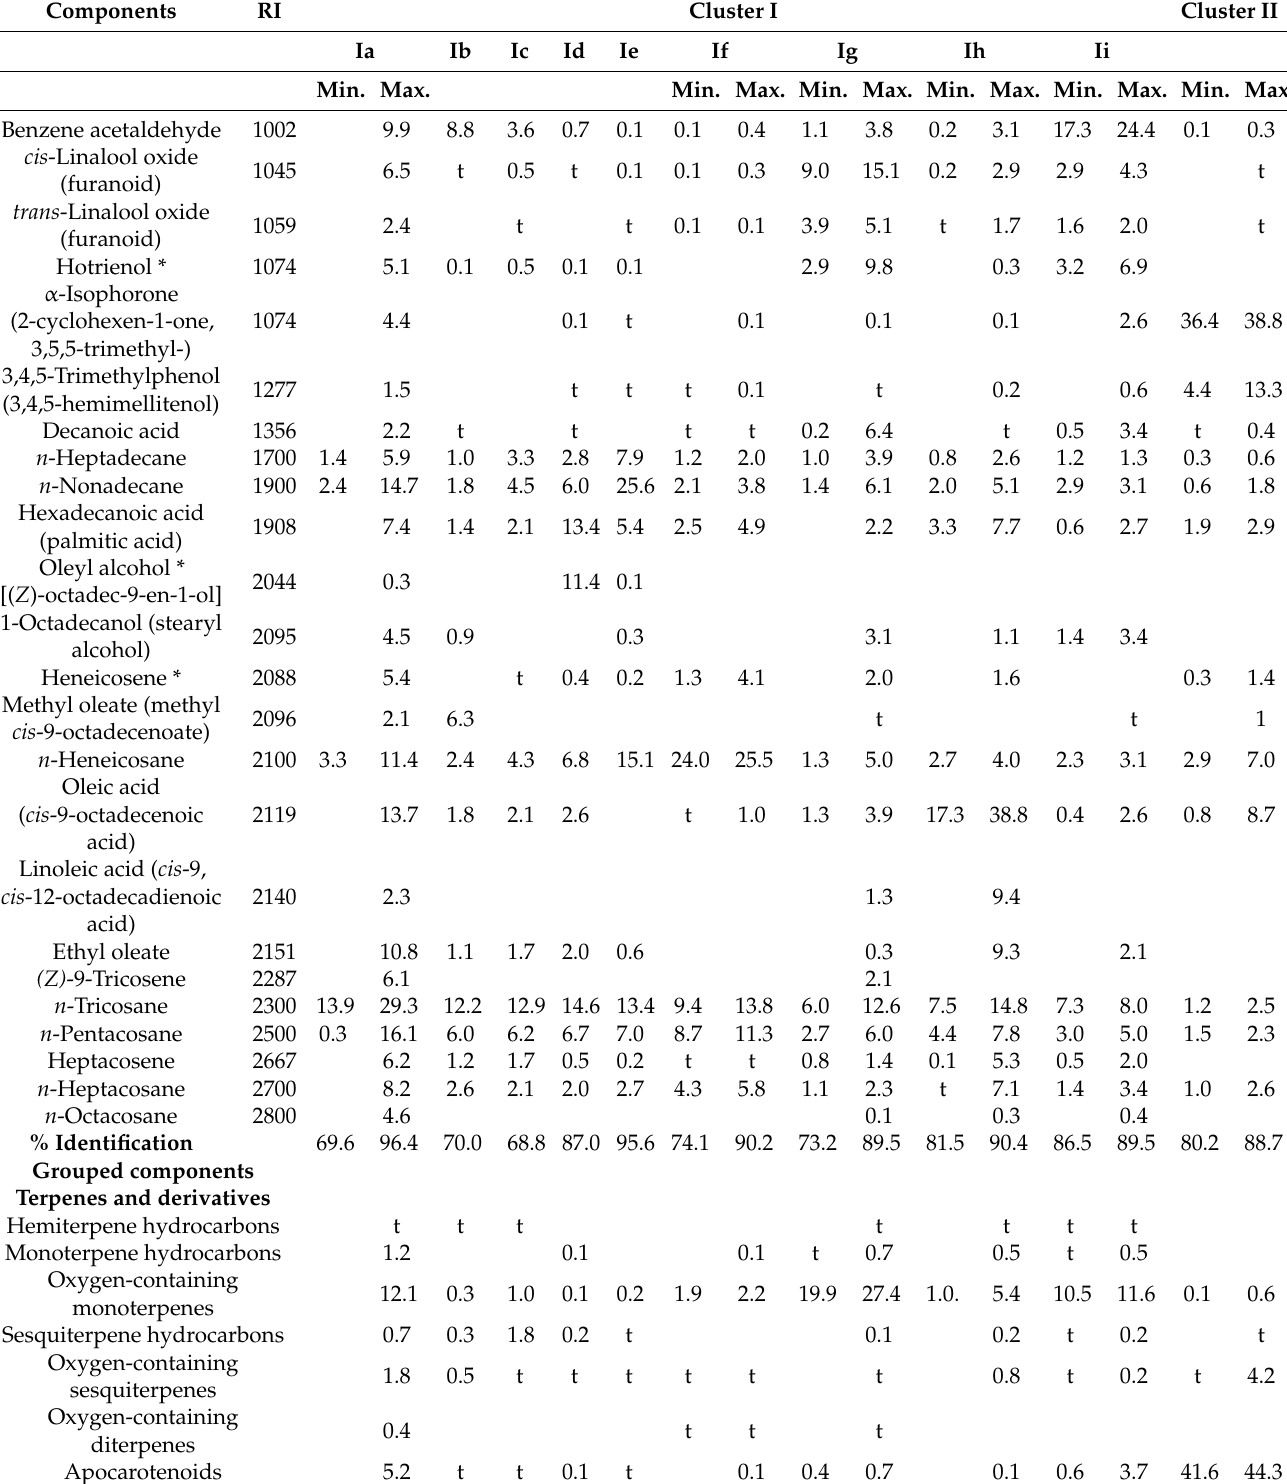
Table 2. Minimum and maximum percentage range of the main components ( ≥ 5%) isolated by hydrodistillation from the different monofloral honeys grouped according to cluster analysis. For samples grouped in each of the clusters and sub-clusters, see Figure 2. Fully detailed composition is provided in SM Table